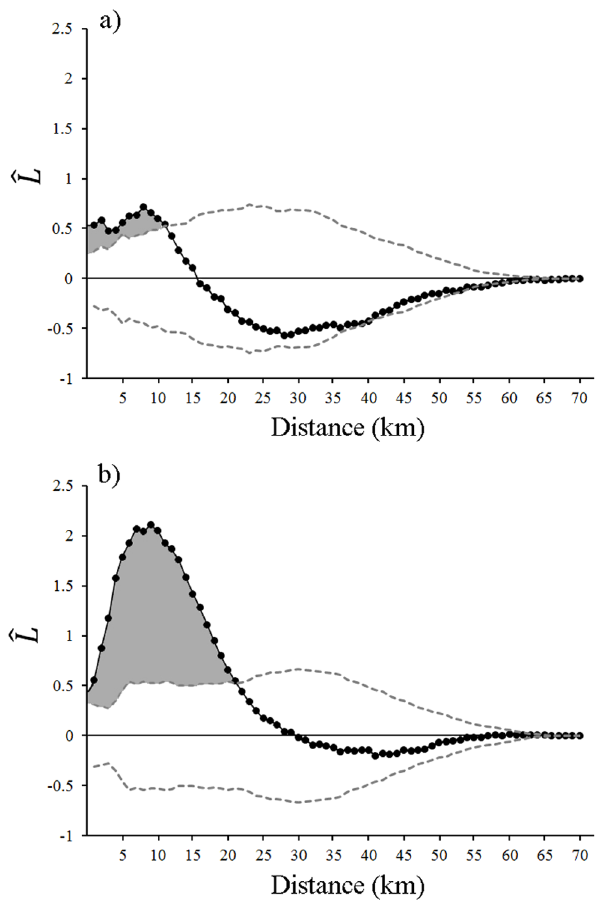
^ t ð Þ values (plotted with black circles Figure 2. The observed L and black line) in relation to distance (km) between locations of a) prime moose and b) senescent moose carcasses in Isle Royale National Park, Lake Superior, USA, 2000–2008. Expected L(t) values are represented by the horizontal line at 0, 99% confidence intervals are depicted with the hatched lines, and significant spatial clustering of carcass locations at the a =0.01 level is represented by the grey shading.